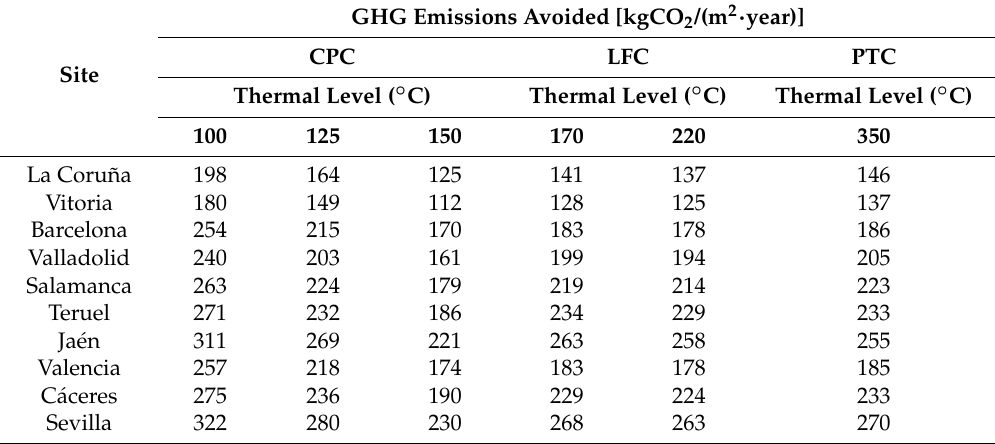
Table 29. GHG emissions annually avoided by the use of solar technologies instead of fuel oil.